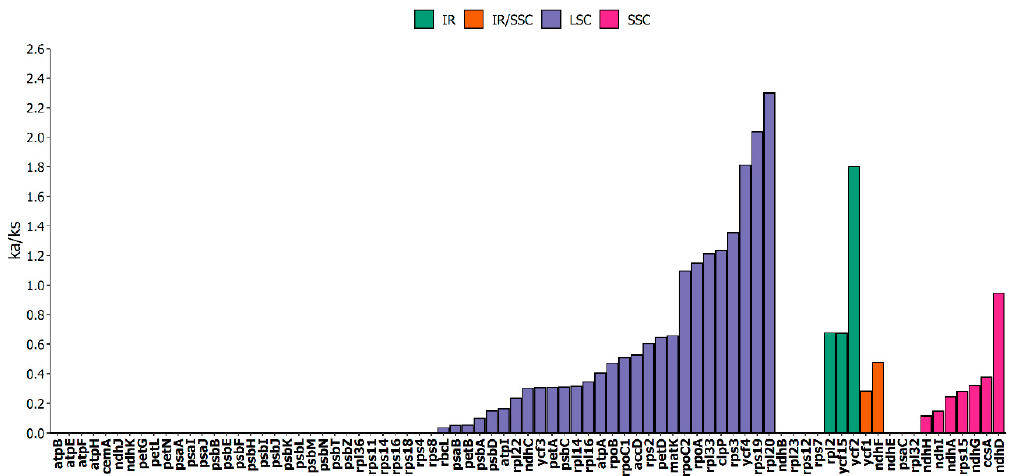
Figure 4. The Ka / Ks ratios recorded for individual genes in the A. camansi and A. heterophyllus Figure 4. The Ka/Ks ratios recorded for individual genes in the A. camansi and A. heterophyllus plastid plastid genomes.